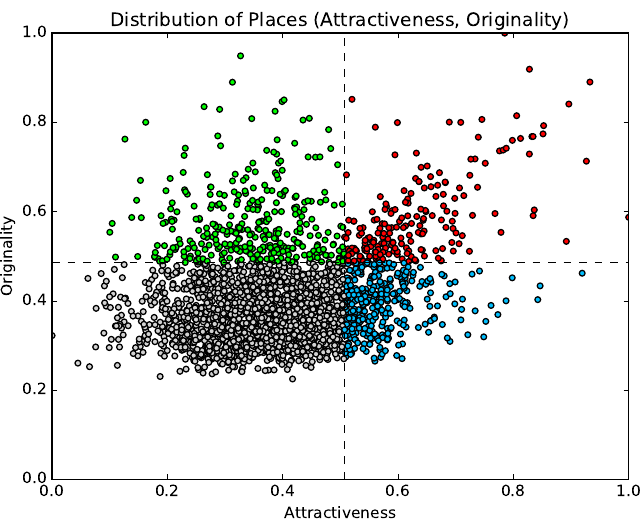
Figure 3. Distribution of attractiveness and originality: The proposed method extracts locations with both top 20% originality and top 20% attractiveness and regards them as tourist